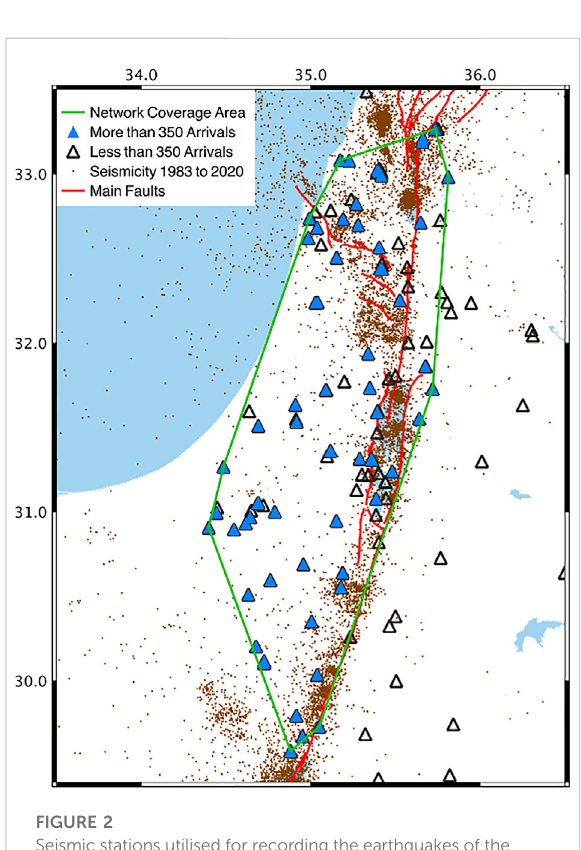
FIGURE 2 Seismic stations utilised for recording the earthquakes of